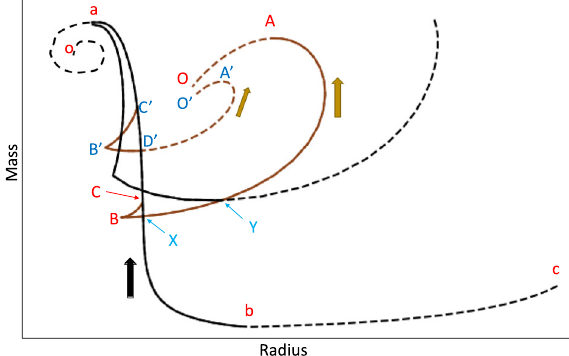
Fig. 17 Some typical examples for the stability regimes of the M – R curve of the third scenario hybrid stars. The black curves are NS- like and the brown curves are DM-like, which are defined in the main text. The block arrows indicate the directions of increasing of the core pressures. We use the (reverse) BTM criteria discussed in the main text to determine the stable/unstable regimes, which are indicated by solid/dottedparts.Acaveatfortheintersectionpointisasfollows.Since the mass and radius depend on both the core pressures of nuclear and dark matter, some intersection points may be the faked ones and cannot be used to judge the saddle (in)stability. For examples, the intersection points C and Y are real ones, while the point X is a fake intersection point. For more details, see the main text